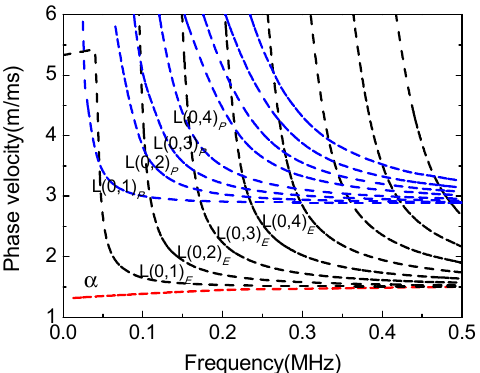
Figure 3. Dispersion curves of guided waves in water-filled pipe embedded in finite porous medium of porosity 0.1. The thickness of the finite porous medium is d = 0.05 m. Red, black, and blue lines represent three kinds of modes: α mode, L(0, m ) E , and L(0, m ) P ( m = 1,2,3, . . . ,8), respectively.